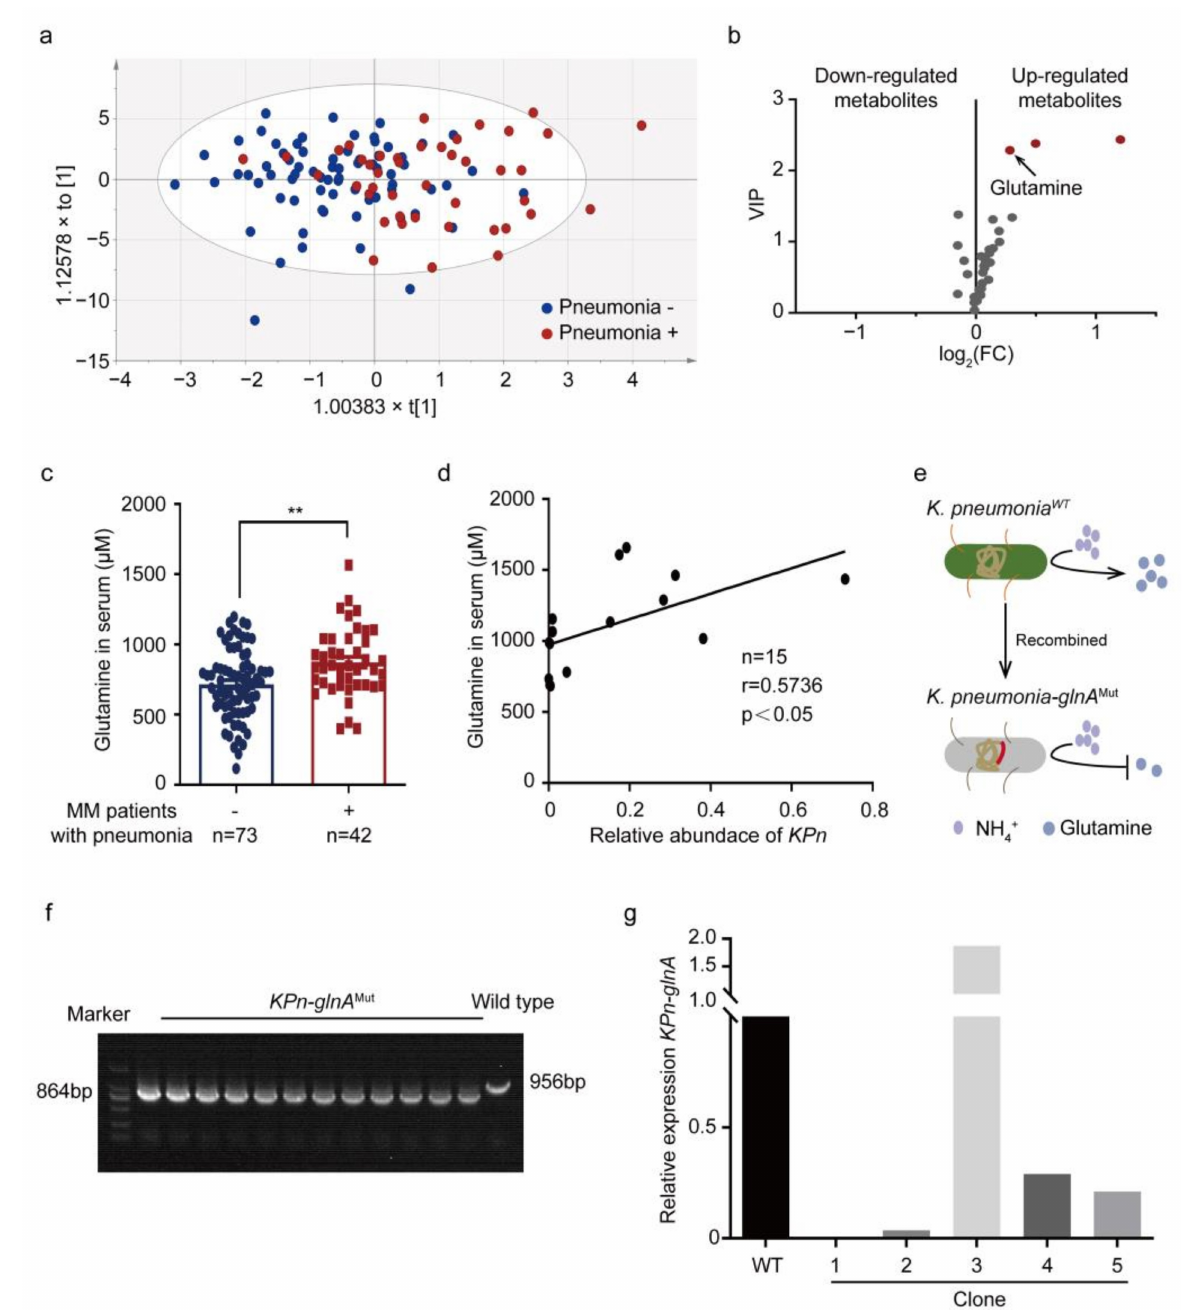
Figure 3. Glutamine is elevated in PB plasma of MM patients with pneumonia. ( a ) A plot of OPLS- DA scores for the PB plasma derived from MM patients without pneumonia (n = 73) and with pneumonia (n = 42); ( b ) differential metabolites based on VIP, FC, and p -value. Annotated metabolites were analyzed at the univariate level by using MetaboAnalyst 3.0 software with the nonparametric Student’s t -test; ( c ) targeted metabolomic assays of glutamine in the PB plasma derived from MM patients without pneumonia and with pneumonia (mean ± SEM); ( d ) the Pearson correlation between relative abundance of intestinal K. pneumonia and serum glutamine concentrations from paired fecal and serum samples in newly diagnosed MM patients; ( e ) K. pneumonia containing mutant glnA was constructed; ( f ) the DNA agarose gel electrophoresis of glnA from K. pneumonia wild type and mutant strain; ( g ) relative expression of intestinal K. pneumonia - glnA in K. pneumonia wild type and mutant type; ** p < 0.01; p -value was calculated using two-tailed unpaired Student’s t -tests ( c ); p -value was calculated using Pearson correlation analysis ( d